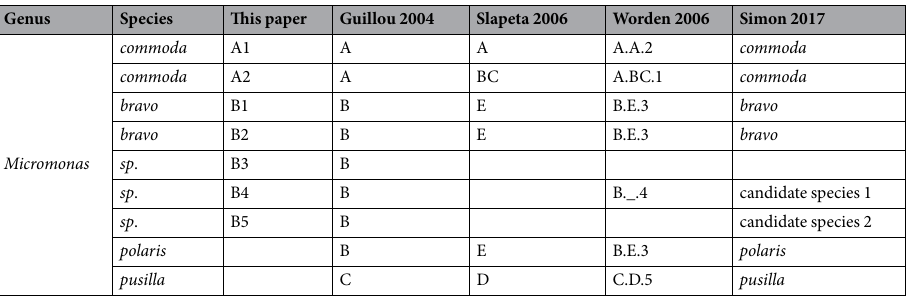
Table 2. Equivalence between the clade nomenclature for the genus Micromonas in this paper compared to those of Guillou et al . 16 , Slapeta et al . 48 , Worden 72 and Simon et al . 11